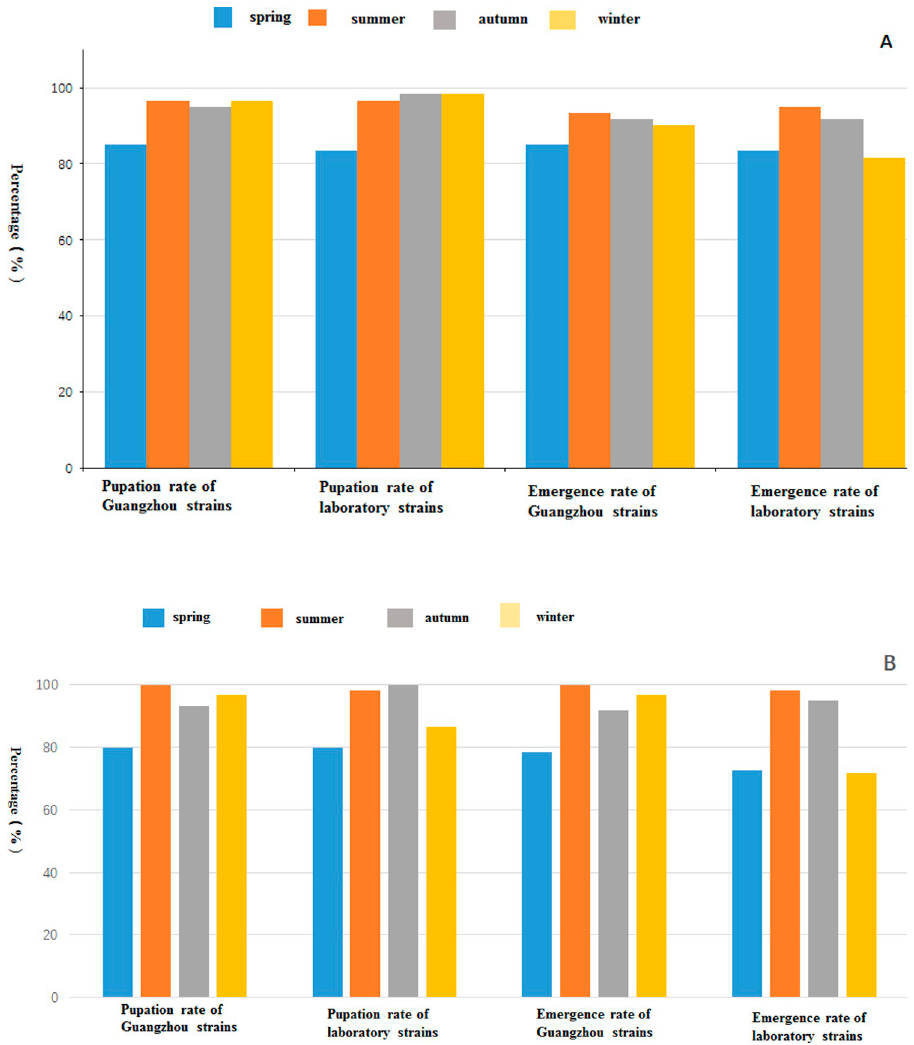
Fig 1. Pupation rate and adult emergence rate of Ae . albopictus in wild conditions (A) and laboratory conditions (B).